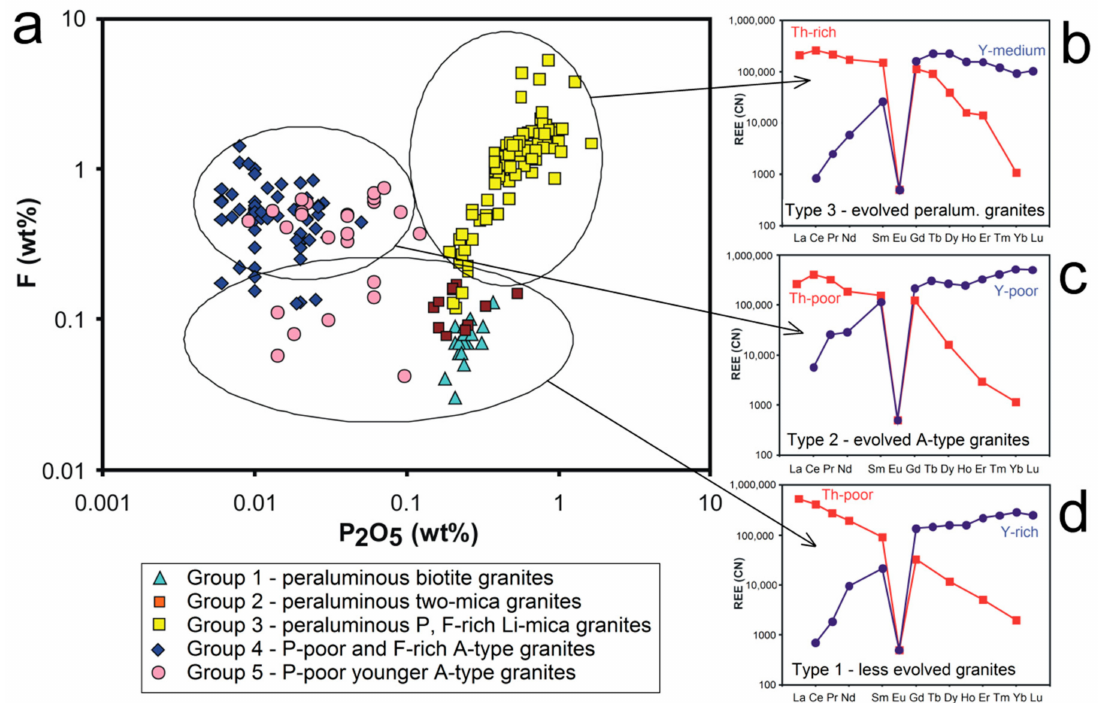
Figure 10. Chemical composition of Erzgebirge granites in terms of F versus P 2 O 5 ( a ) and the related typical chondrite- normalized REE patterns of monazite and xenotime ( b – d ). Red patterns—monazite; blue patterns—xenotime. Classification of granites according to [12], bulk-rock data from [9,12,14,19,23,34] and unpublished data. See text for